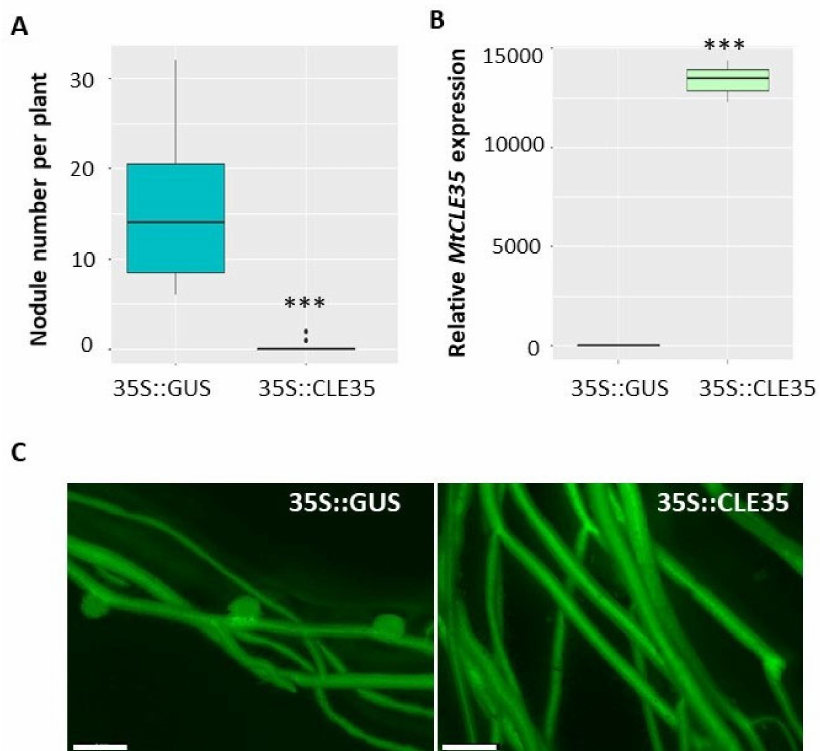
Figure 4. MtCLE35 overexpression inhibits nodulation in wild-type plants. ( A ) Nodule number in wild-type (A17) A green fluorescent protein (GFP)-positive transgenic roots transformed with the 35S :: GUS (control) or 35S :: MtCLE35 construct. Asterisks indicate statistically significant di ff erences (Mann-Whitney U test, p < 0.001). ( B ) The expression level of the MtCLE35 gene in GFP-positive transgenic roots transformed with the 35S :: GUS (GUS_OE, control) or 35S :: MtCLE35 construct. Asterisks indicate statistically significant di ff erences p < 0.001. Box plots are presented with median values. ( C ) Examples of the nodulation phenotype of GFP-positive transgenic roots carrying the 35S::GUS (control) or 35S::MtCLE35 construct on wild-type plants. Bars = 1000 µ